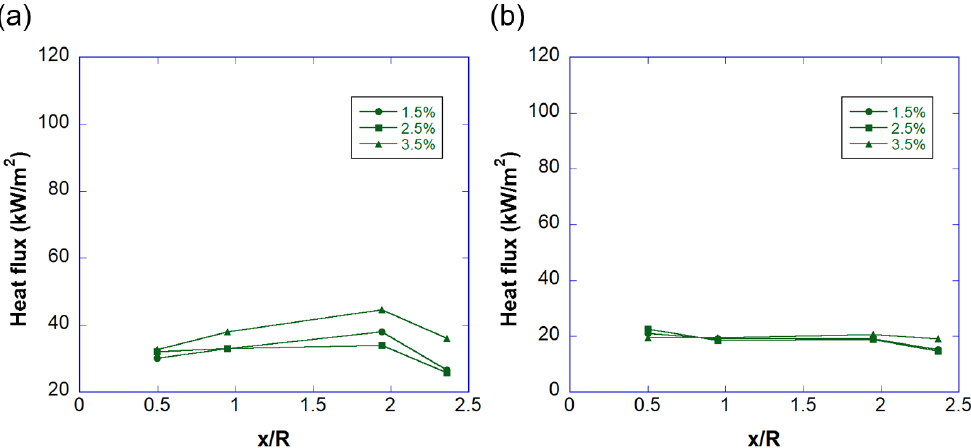
Figure 9. Heat flux from the oxy-fuel flame to the combustion chamber wall for different flue gas O 2 concentrations: ( a ) 100% and ( b ) 50% loads.